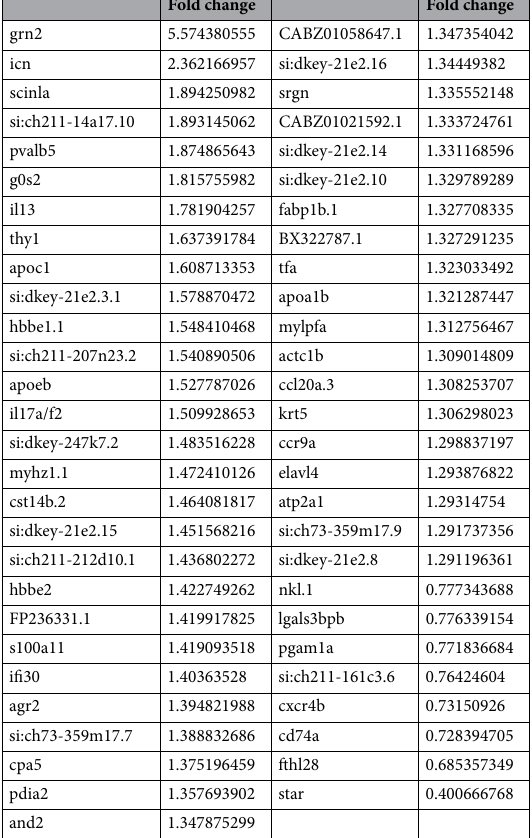
Table 1. Microglial DEG with DEPe exposure.